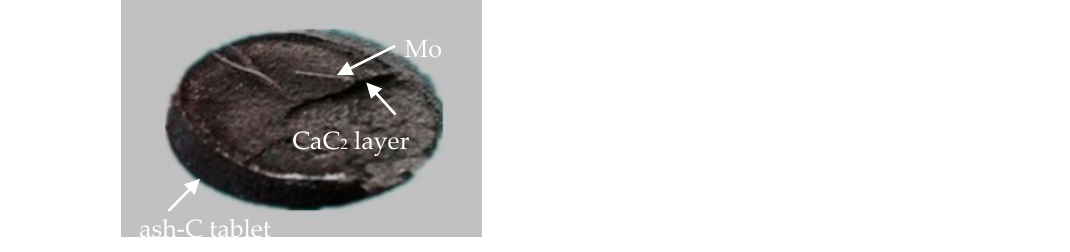
Figure 7. Location of Mo wires after the sample (CaO+ash-C with Mo wires) after the heat treatment at 1700 °C.